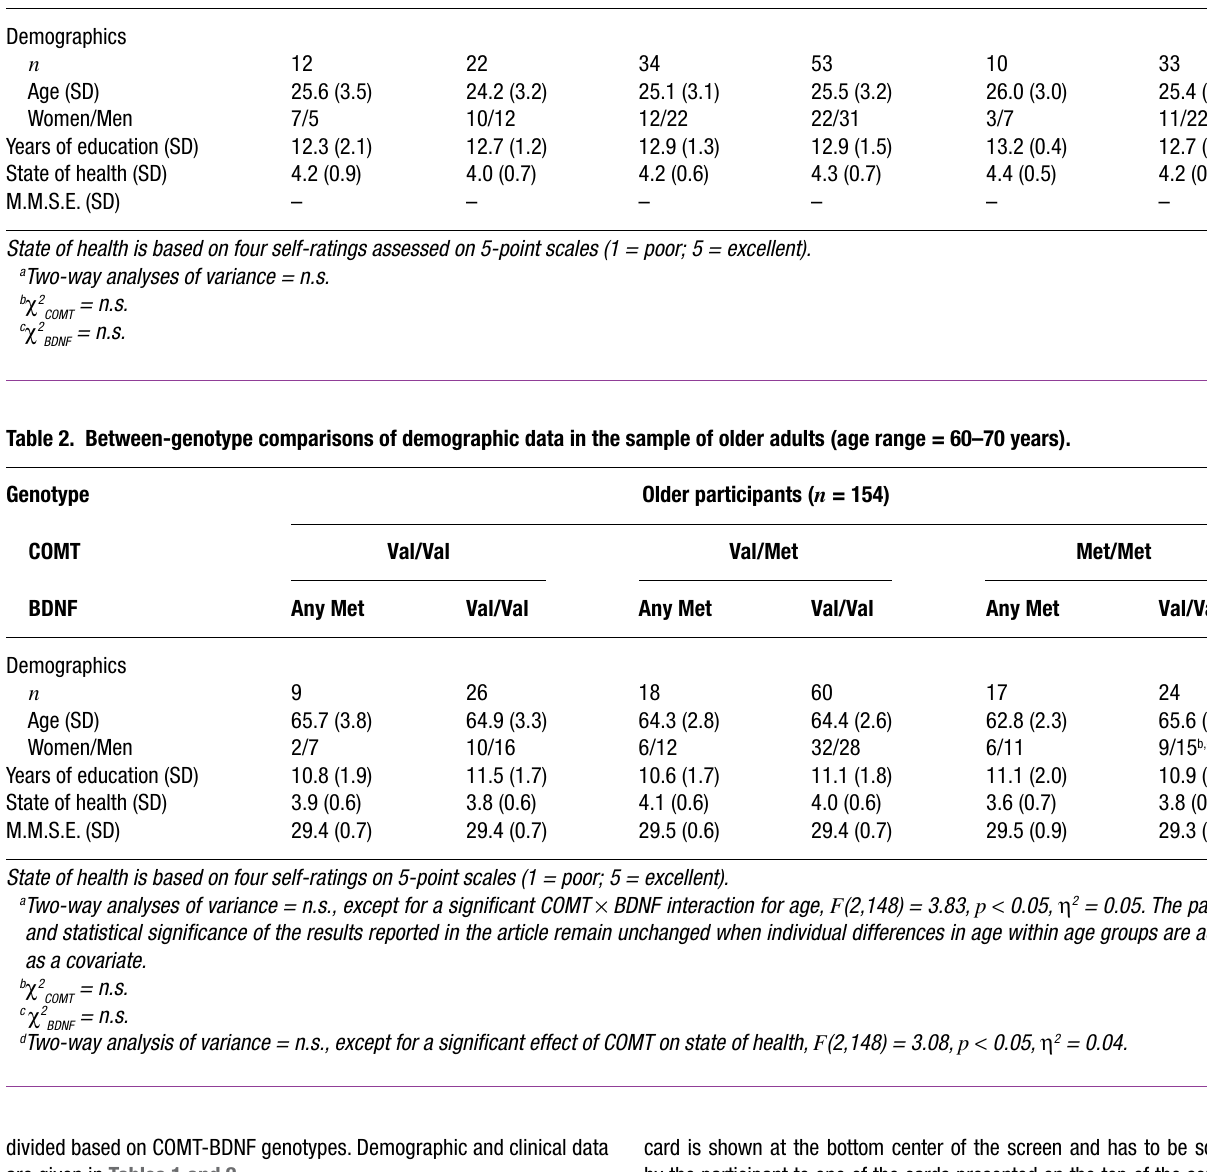
Table 1. Between-genotype comparisons of demographic data in the sample of younger adults (age range = 20–30 years). Genotype